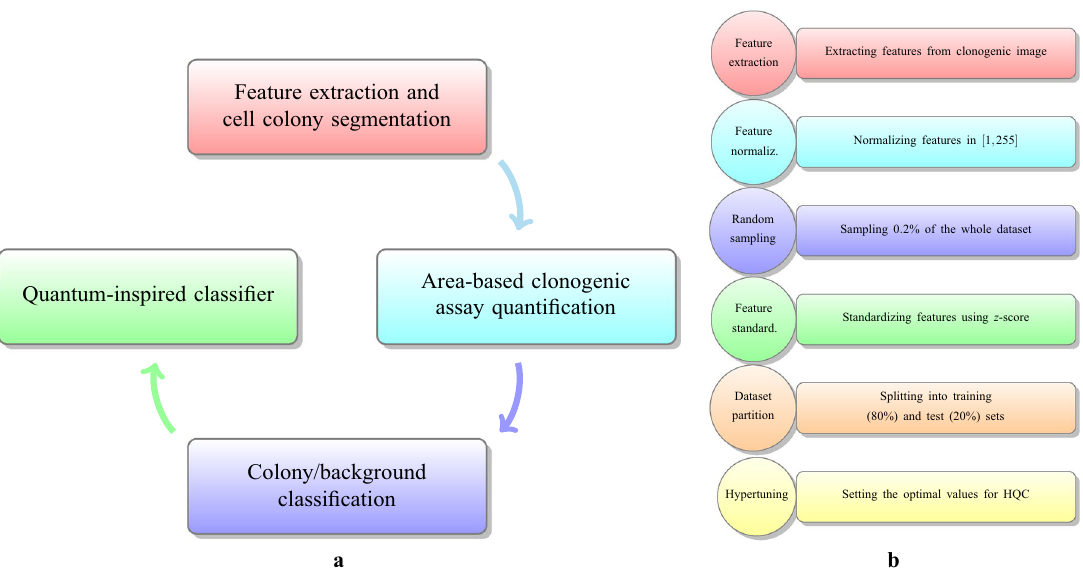
Figure 2. Conceptualization. The general scheme of the process: ( a ) conceptual scheme of the proposed multidisciplinary approach involving image processing, machine learning, quantum information theory and cell biology. ( b ) The pre-processing